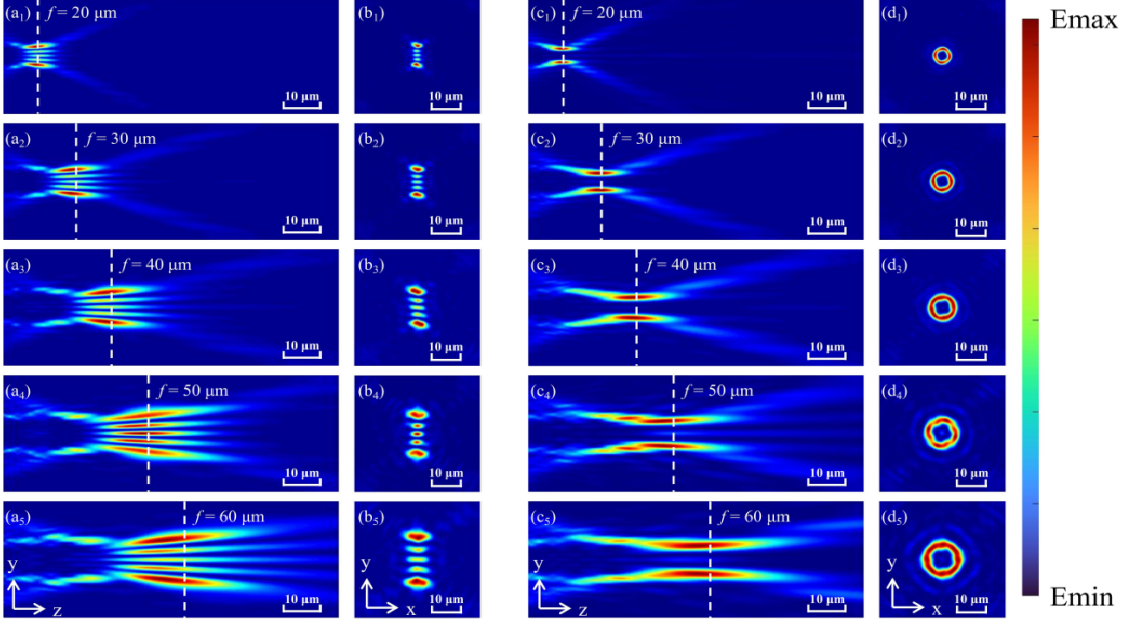
Figure 9. The influence of different focal wavelengths on the OVB generators. ( a ) corresponds to the LOCP of the YOZ plane. ( b ) corresponds to the LOCP of the YOX plane. ( c ) corresponds to the HOCP of the YOZ plane. ( d ) corresponds to the HOCP of the YOX plane.